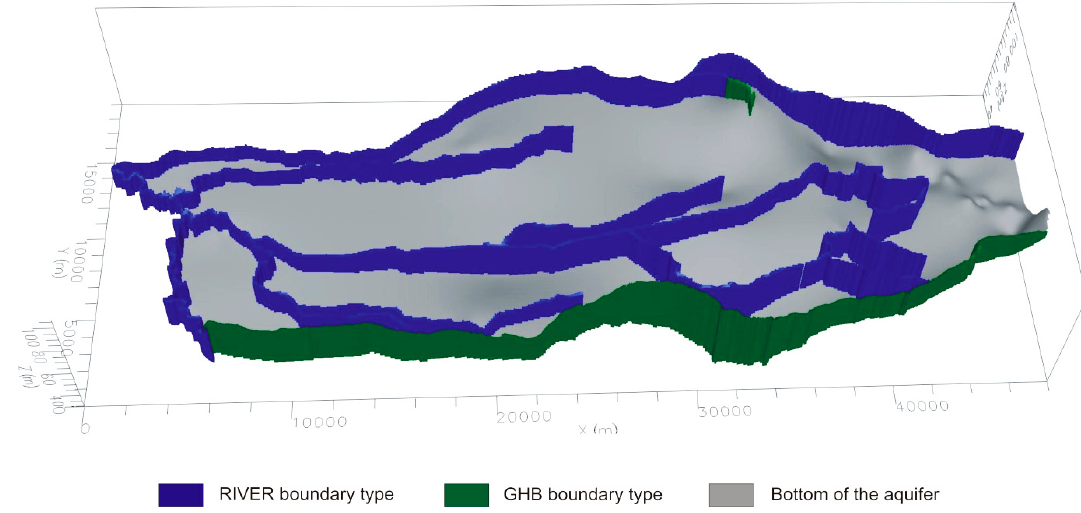
Figure 5. The boundary conditions and the discretization net of the modelled area.